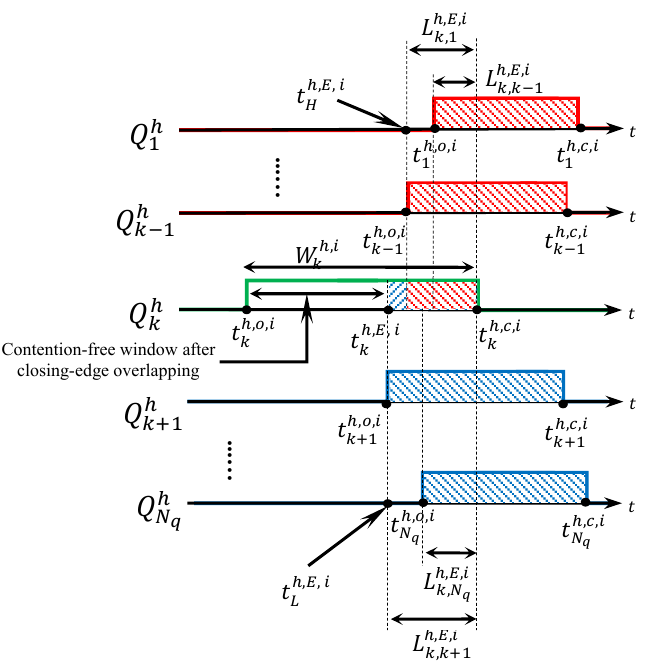
Figure 8 . Closing-edge overlapping with higher- and lower-priority windows. Figure 8. Closing-edge overlapping with higher- and lower-priority